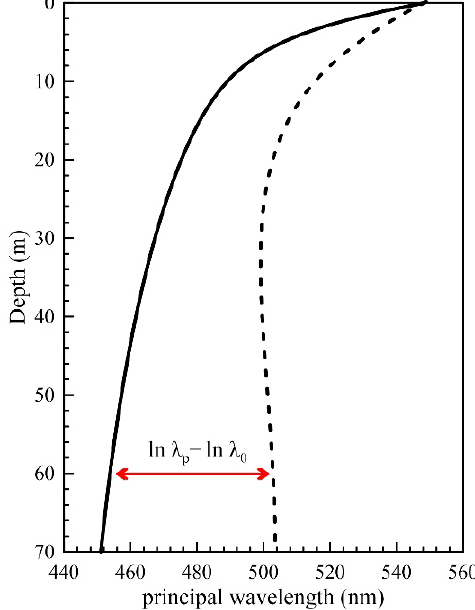
Figure 8. Schematic diagram of the relationship between the principal wavelength and chlorophyll-a concentration. The black line is the average principal wavelength of pure seawater ( λ p 0 ), and the dotted line represents the schematic profile of the principal wavelength in Case I seawater. The difference between the two at 60 m is displayed.